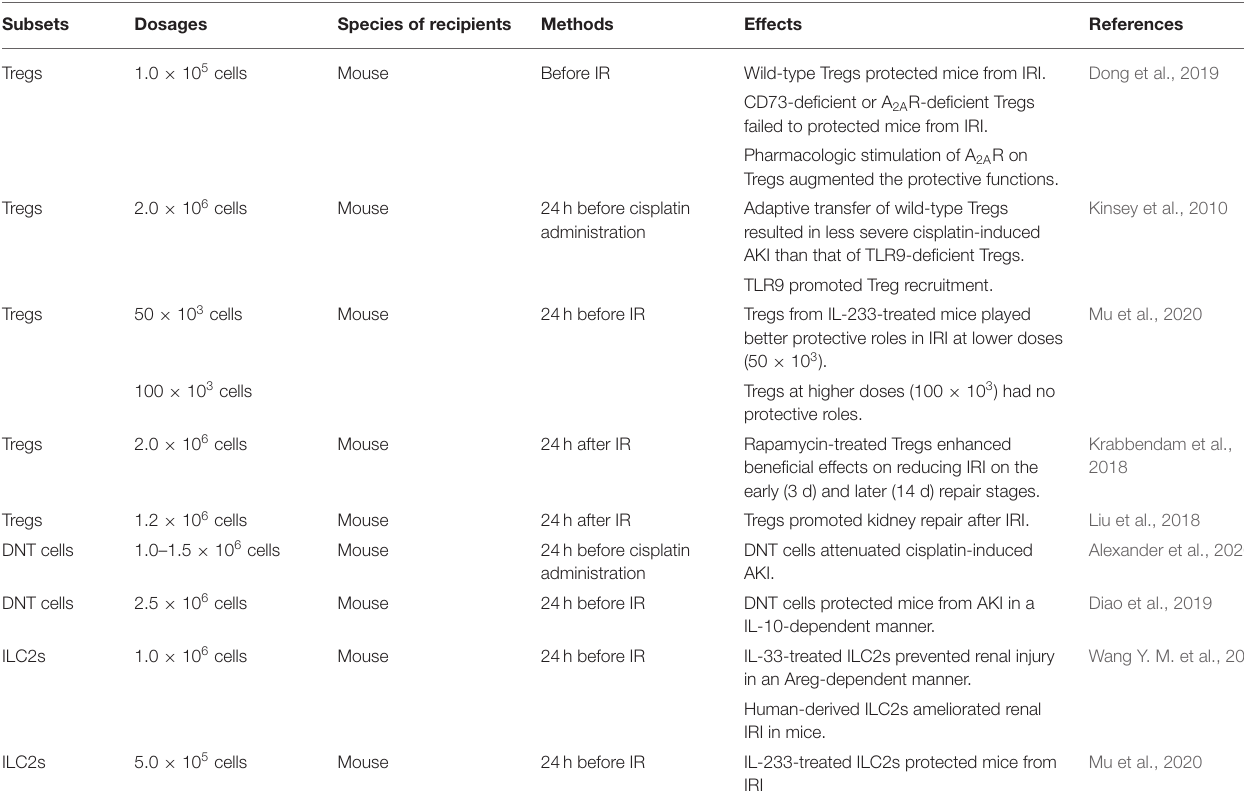
TABLE 4 | Adaptive transfer of ex-expanded